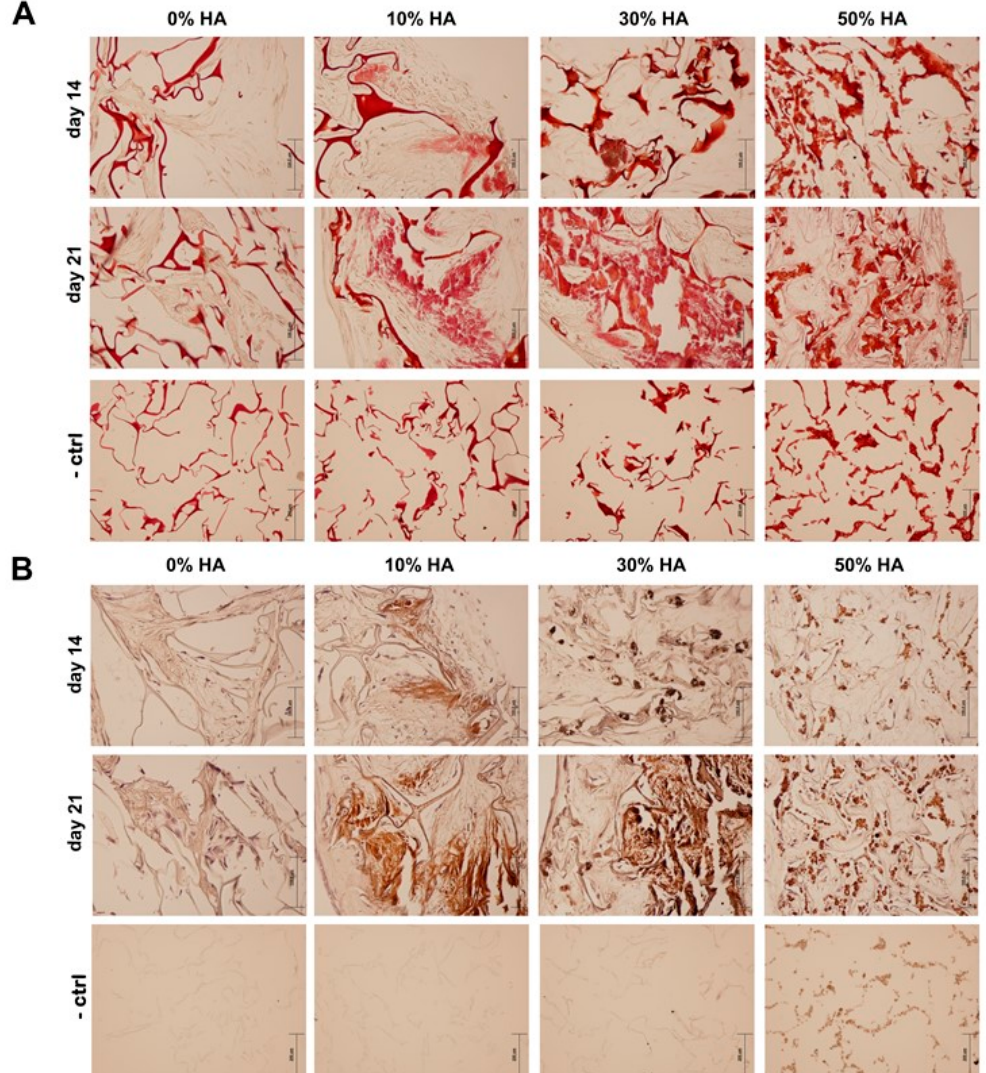
Figure 7. Assessing the mineralization of hMSCs grown in an osteogenic medium within different scaffolds after 14 and 21 days. ( A ) Mineralization of the extracellular matrix with the presence of calcium precipitates was visualized by staining with alizarin red S at days 14 and 21. Positive staining for calcium is signified by red color; ( B ) detection of mineralization using von Kossa staining (including hematoxylin counterstain). Positive staining for calcium phosphate is signified by brown color. Representative images are shown at 200× magnification ( n = 3) and the scale bars represent 100 µm, respectively. Scaffolds without hMSCs were used as negative controls ( − ctrl). Representative images of negative controls are shown at 100× magnification ( n = 3) and the scale bars represent 200 µm.